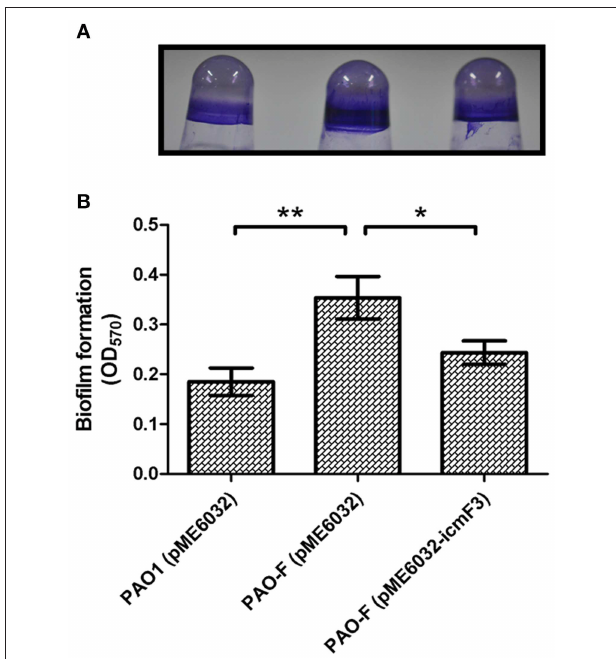
FIGURE 10 | Deletion of icmF3 affects biofilm formation. Cells were grown for 24h in PVC 96-well plates containing LB, 1mM IPTG and 160 µ g ml − 1 tetracycline. Biofilm formation the strains was determined by crystal violet staining (A) and quantified using optical density measurement (B) . * P < 0.05 , ** P < 0.01